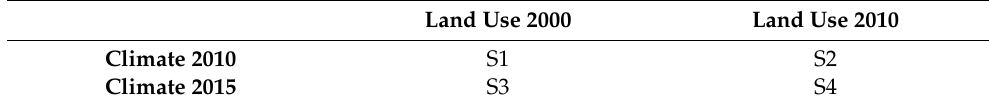
Table 3. Land use and climate scenario settings. Land Use 2000 Land Use 2010 Climate